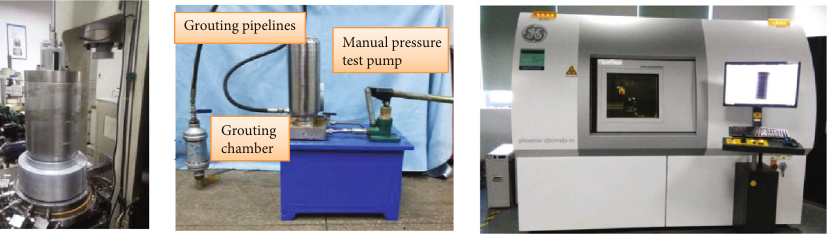
Figure 7: Experimental systems.